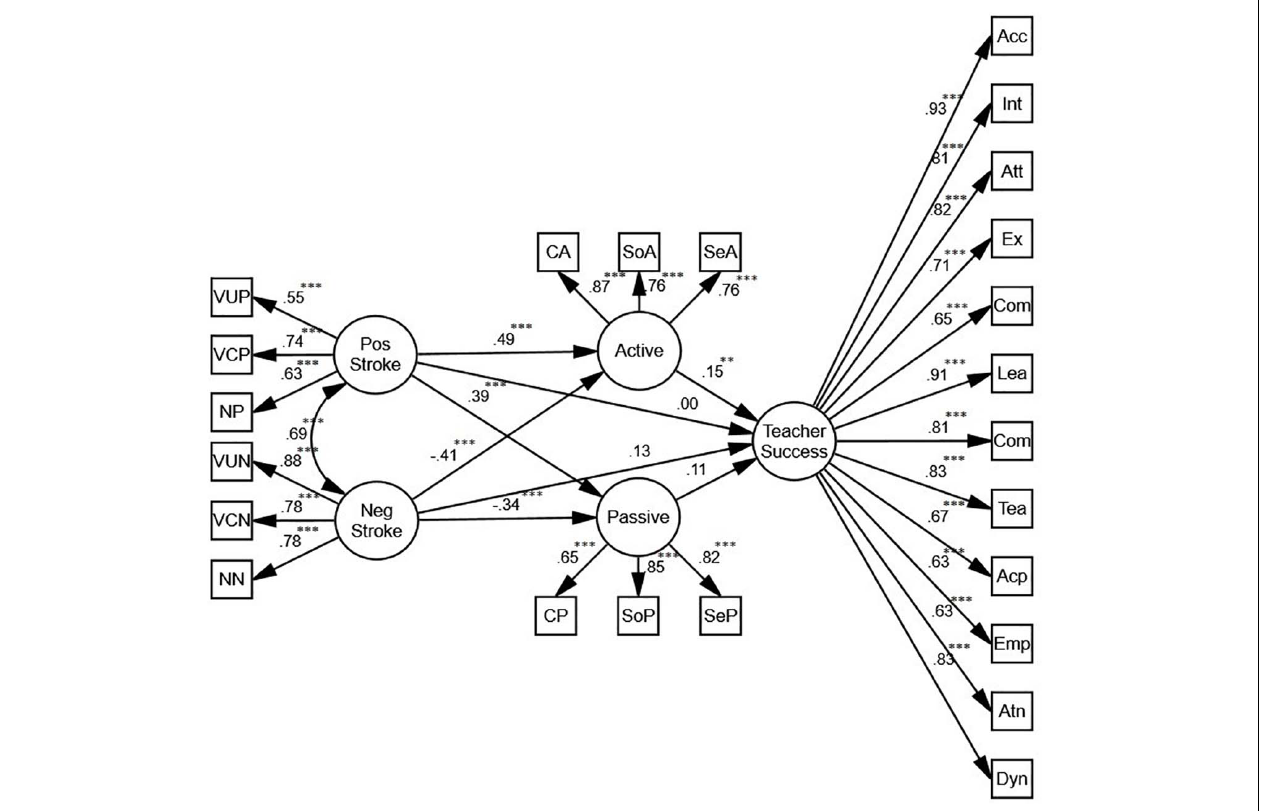
FIGURE 4 | The schematic representation of the relationships between positive (pos) and negative (neg) stroke, active and passive motivation, and teacher success (** p < 0.01, *** p < 0.001).